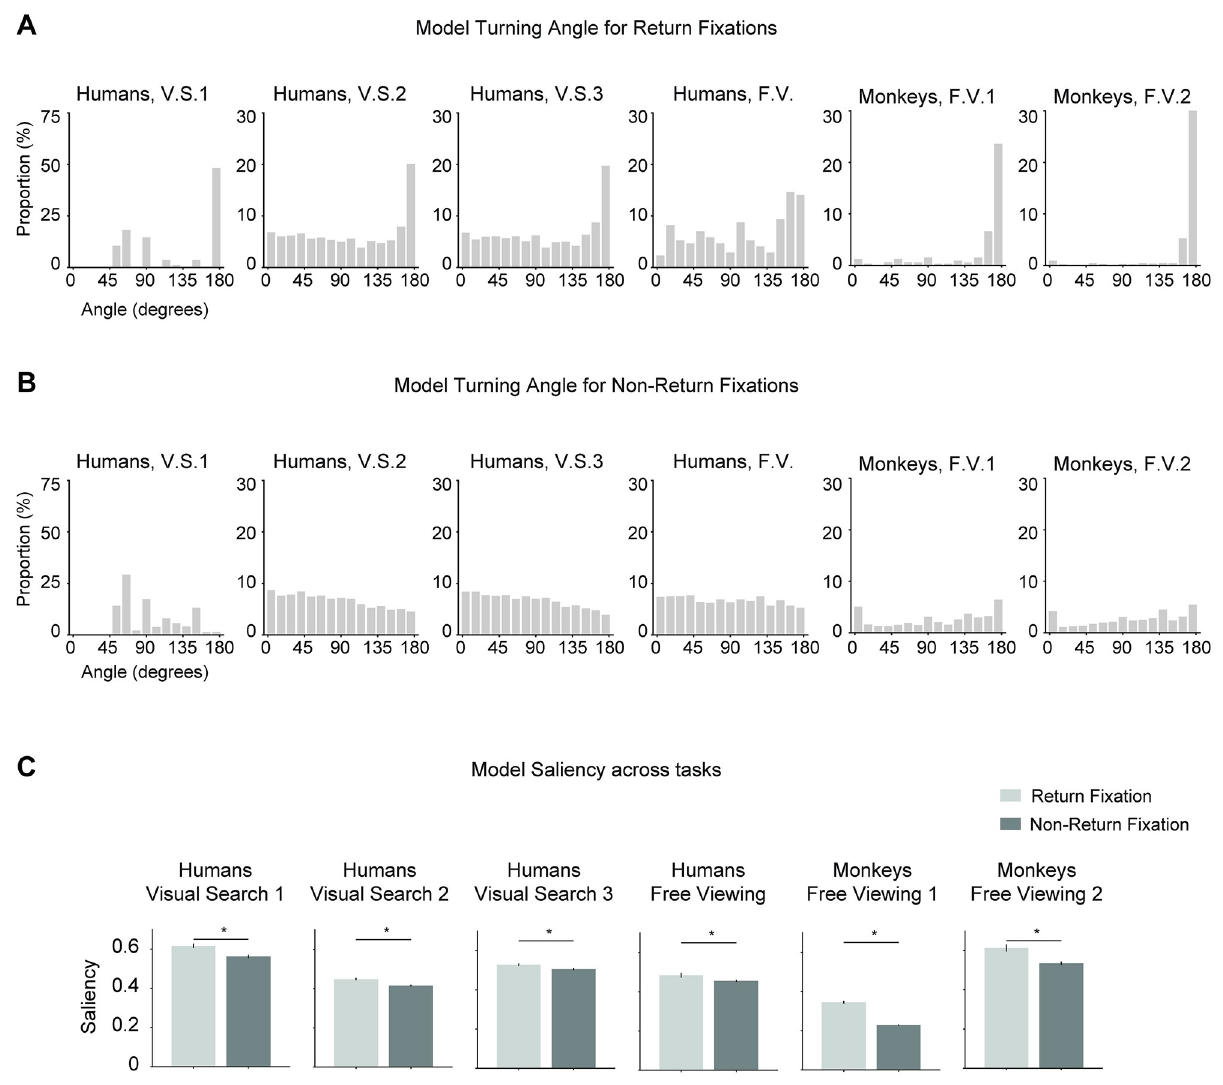
Fig 9. The computational model captures return fixation turning angles and saliency. Distribution of turning angles preceding return fixations ( A ) and non-return fixations ( B ) for the model (format as in Fig 5A–5B). ( C ). Saliency at return fixation locations and non-return fixation locations for the model (format as in Fig